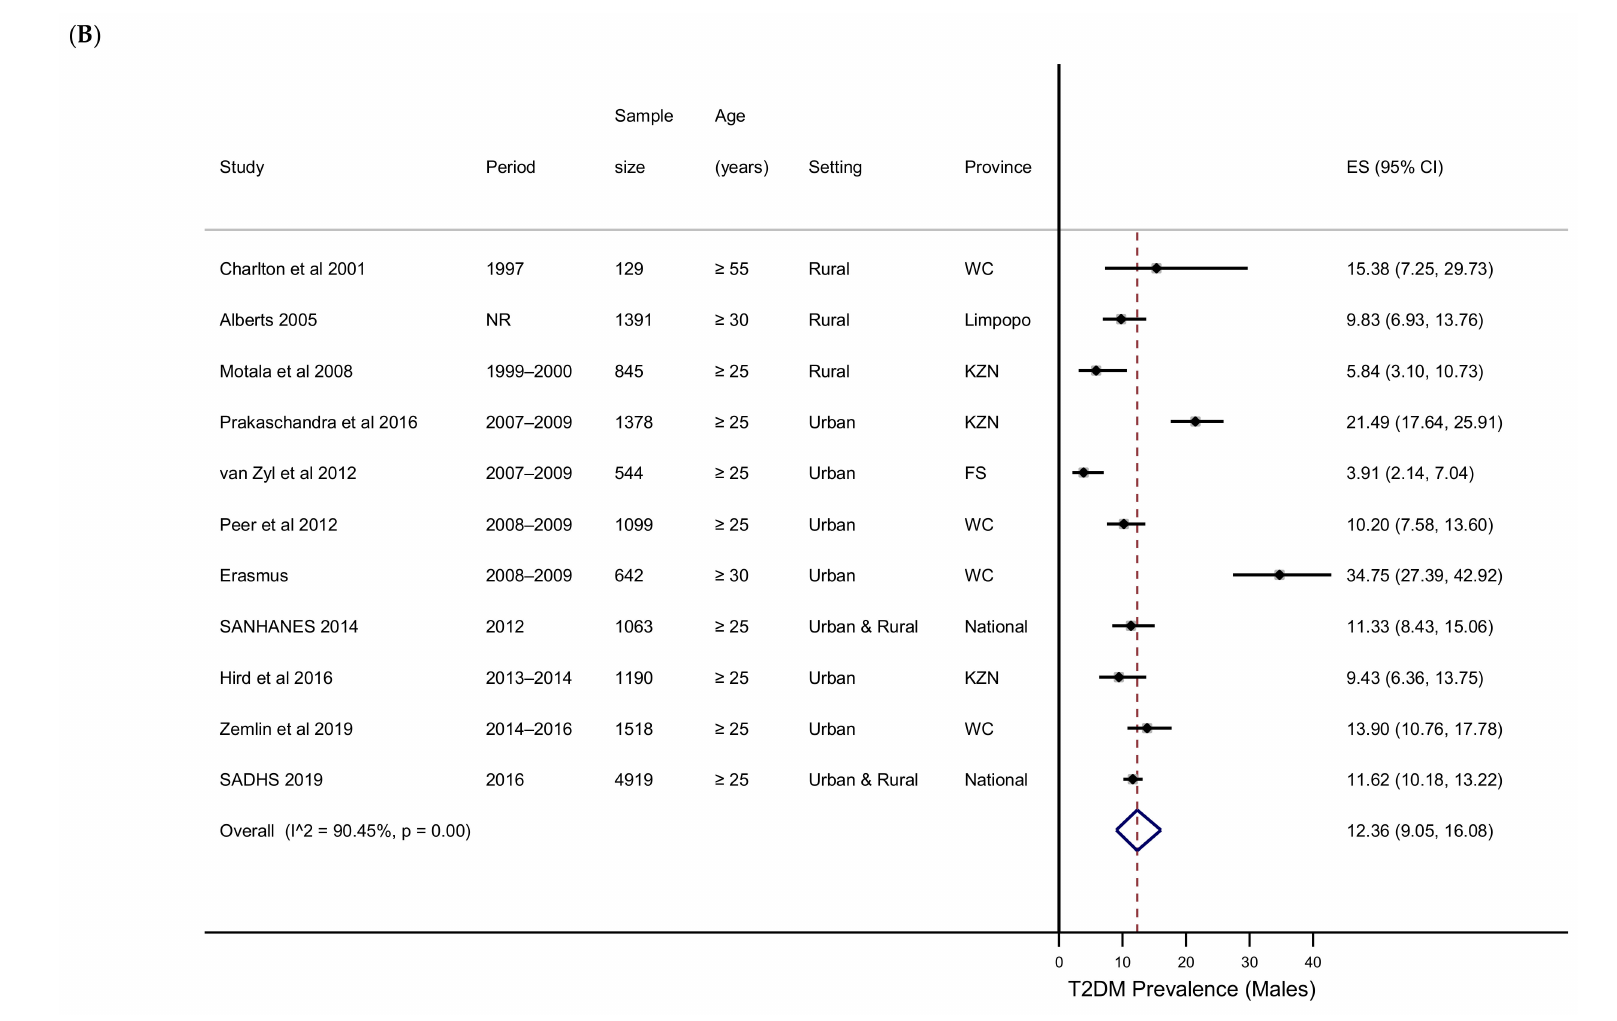
Figure 3. T2DM prevalence in females ( A ) and males ( B